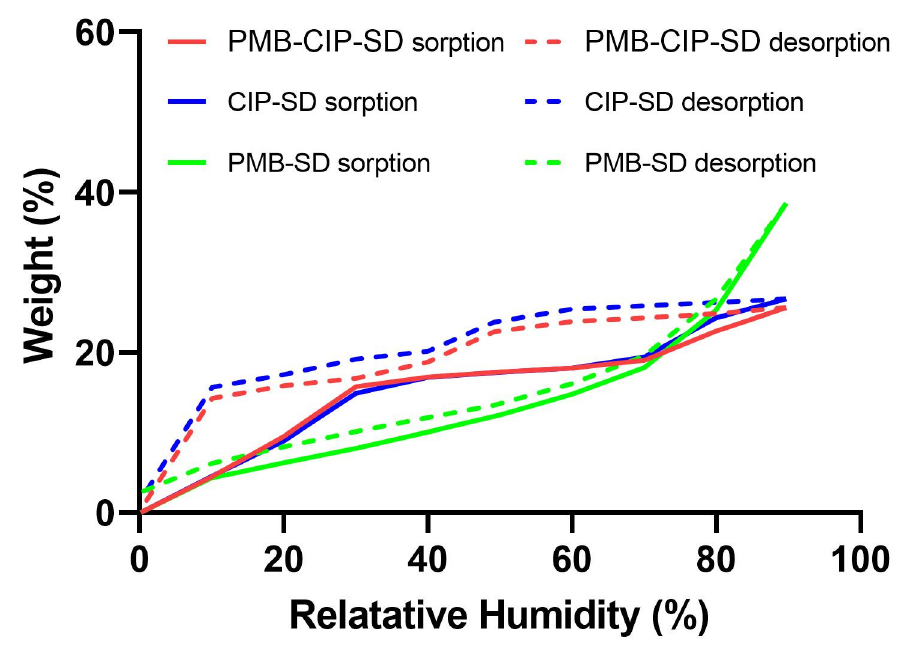
Figure 4. Dynamic vapor sorption isotherm of different formulations. The solid line and dotted line represent the sorption and desorption processes, respectively.